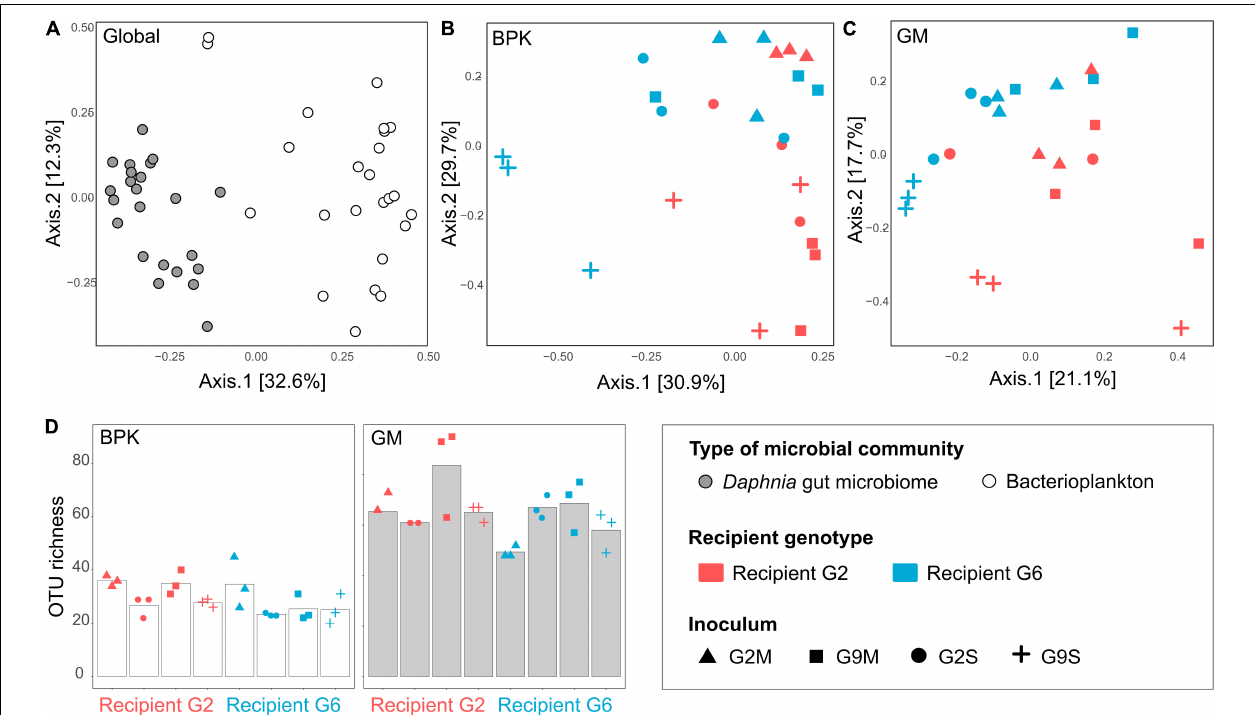
FIGURE 4 | Contribution of recipient Daphnia genotype and microbial source to BPK and GM assembly in the transplant experiment (Experiment 2). (A–C) PCoA of microbial communities 2 weeks after the transplant, using Bray–Curtis dissimilarity indices, when considering all samples simultaneously (A) , BPK samples only (B) , and GM samples only (C) . (D) α -diversity (OTU richness) in the BPK and GM of recipient Daphnia . Bars indicate mean values, points indicate specific values for each